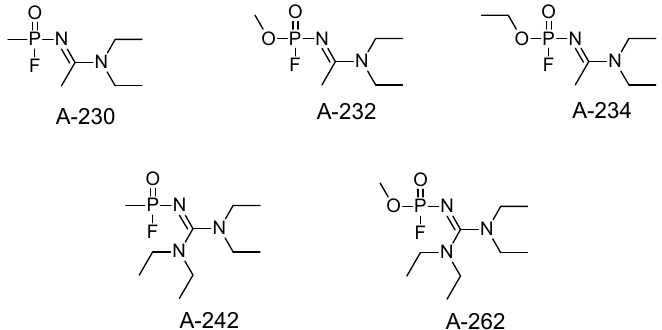
Figure 1. Structures reported by Mirzayanov for the A-series agents developed in the State Scientific Research Institute for Organic Chemistry and Technology (GOSNIIOKhT) by Petr Kirpichev